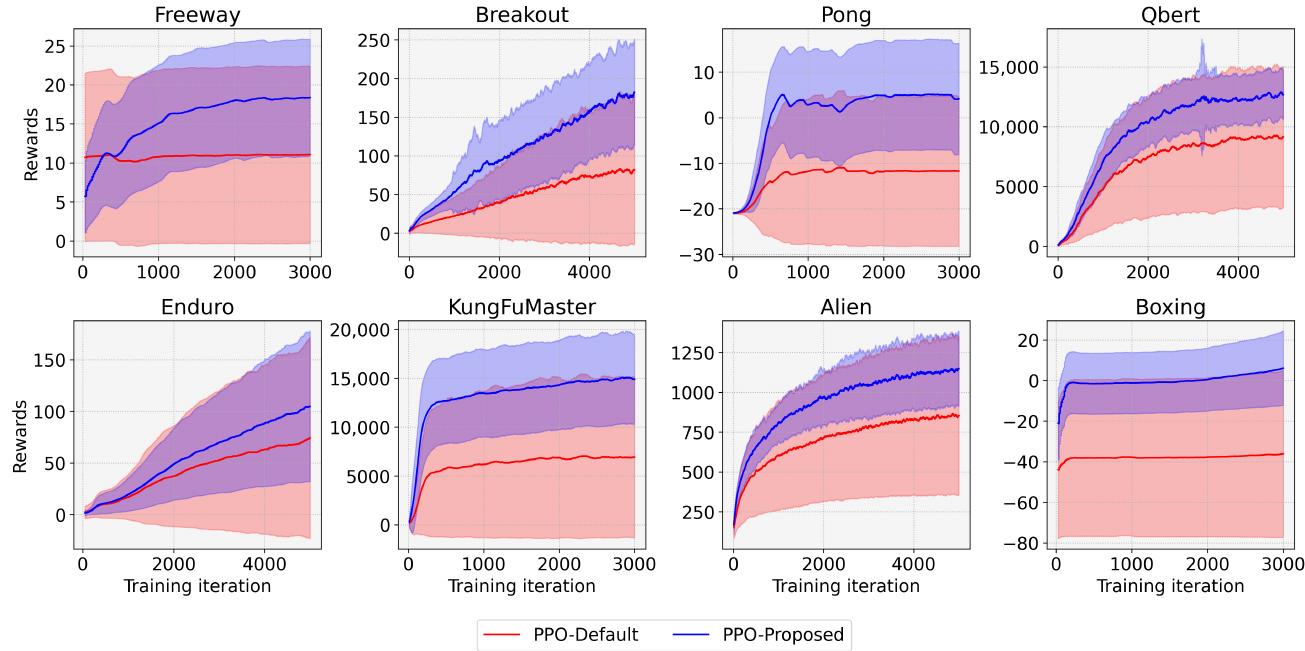
Figure 5. Comparison of the entropy-aware model initialization-based PPO (PPO-Proposed) with the conventional PPO (PPO-Default) for eight